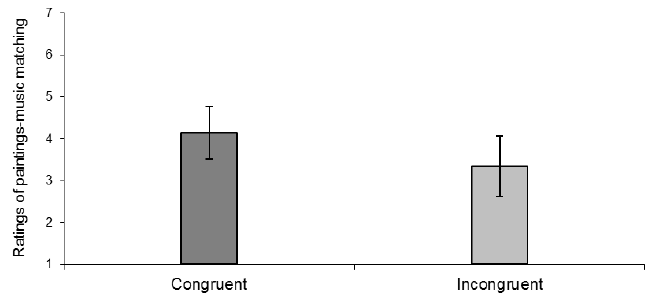
Figure 2. Ratings of paintings-music matching in congruent and incongruent conditions .